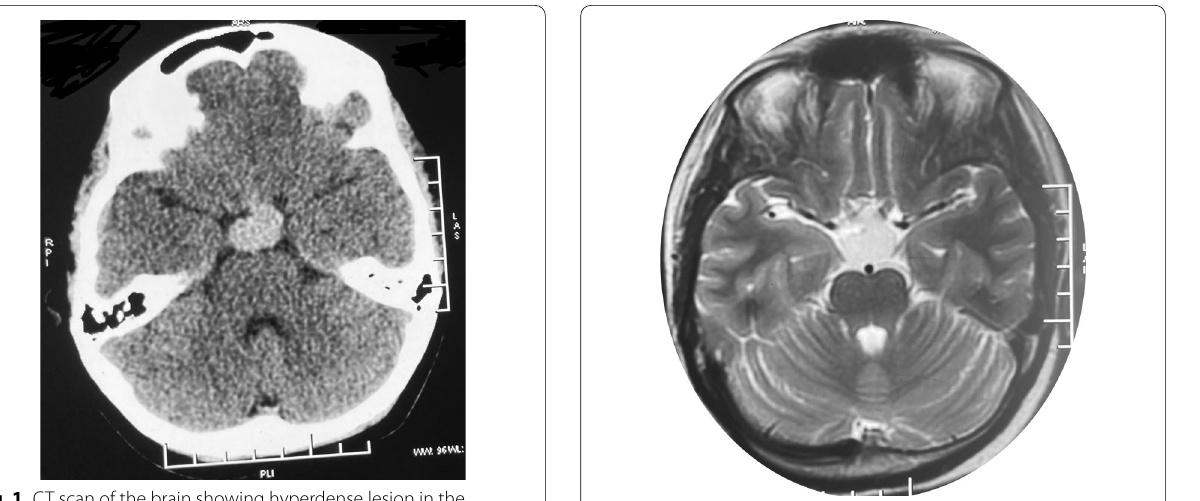
Fig. 3 MRI brain T2 axial image showing the hyperintense suprasellar lesion